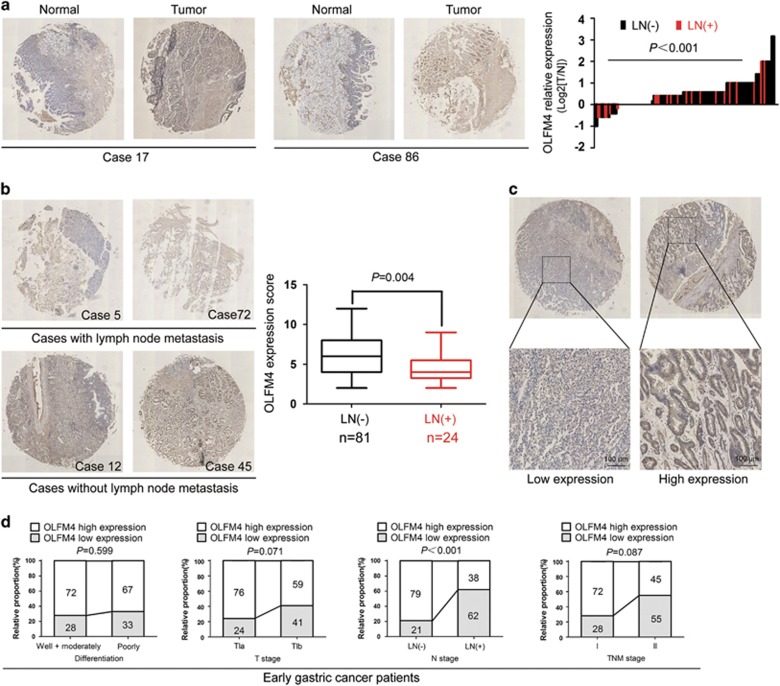
Immunohistochemical staining of the OLFM4 in sections of gastric cancer. (a) Representative tissue microarray of OLFM4 expression in tumor sections and adjacent non-tumor tissues. OLFM4 was highly expressed in tumor sections than non-tumor tissues (P<0.001). Relative OLFM4 expression was calculated as the Log2 value of T-score/N-score. N, matched non-tumor tissue. T, gastric cancer tissue; (b) Representative images of OLFM4 staining in tumor sections from patients with and without LNM. OLFM4 expression score was lower in patients with LNM (mean±s.e.m.: 4.63±0.44) than that in patients without LNM (mean±s.e.m.: 6.52±0.32) (P=0.004). The box plot shows the full range of variation (error bars: min and max) with the line representing median. (c) Representative microphotographs of intratumoral low and high expression of OLFM4 and their regional magnifications; Original magnification: × 200. (d) The percentage of patients with OLFM4 high or low expression according to the differentiation, T stage, LNM and TNM stage in EGC patients.